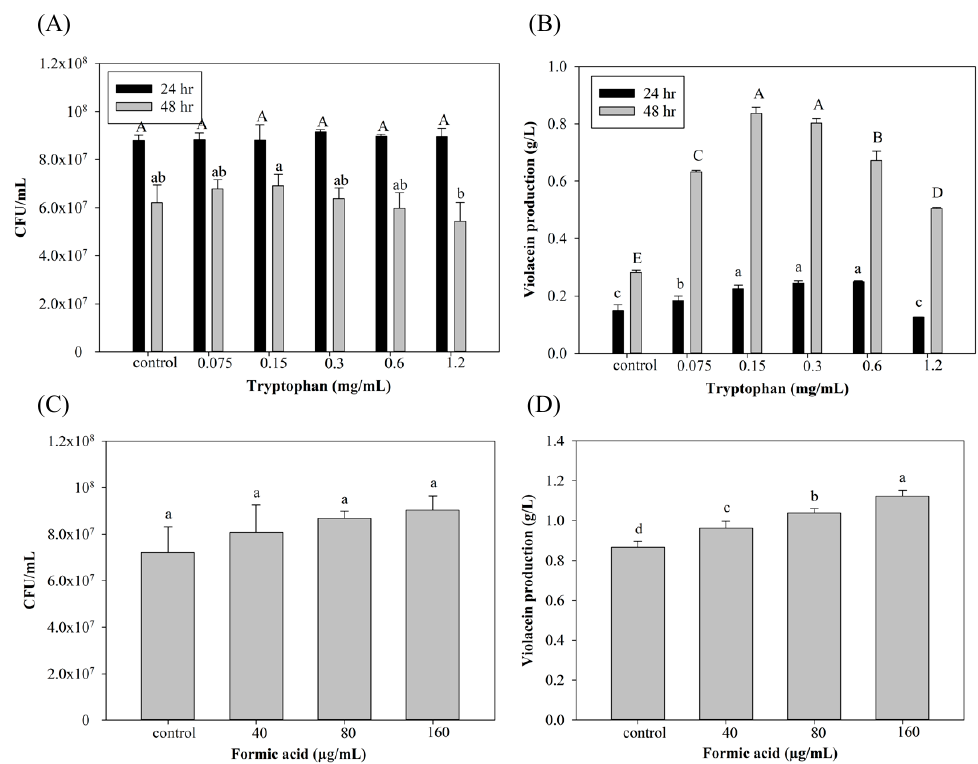
Figure 1. Effect of ( A , B ) tryptophan and ( C , D ) formic acid on cell growth and violacein production of C. violaceum . Each value is expressed as mean ± standard deviation ( n = 3). Different superscripts are significantly different ( p < 0.05).